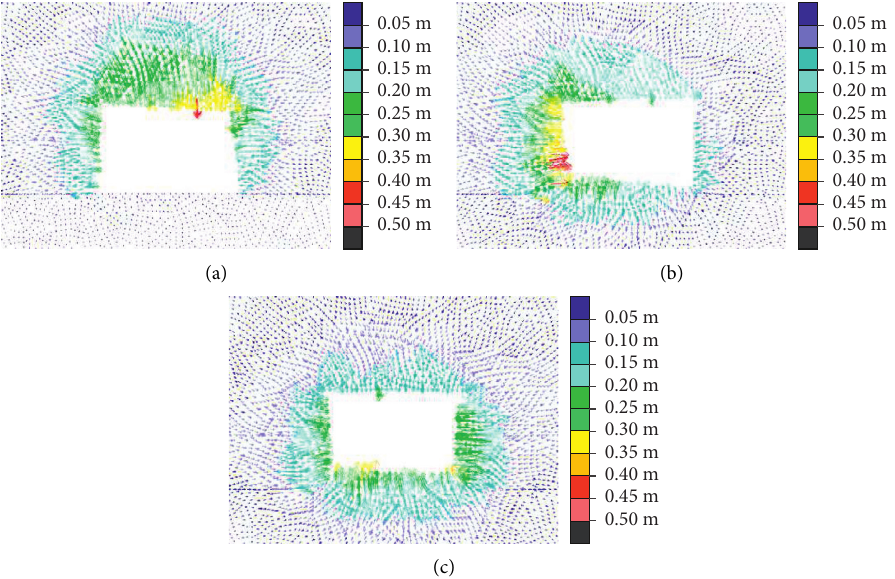
Figure 7: Roadway displacement nephograms with different hypocentral location. (a) Upper hypocenter. (b) Left hypocenter. (c) Bottom hypocenter.